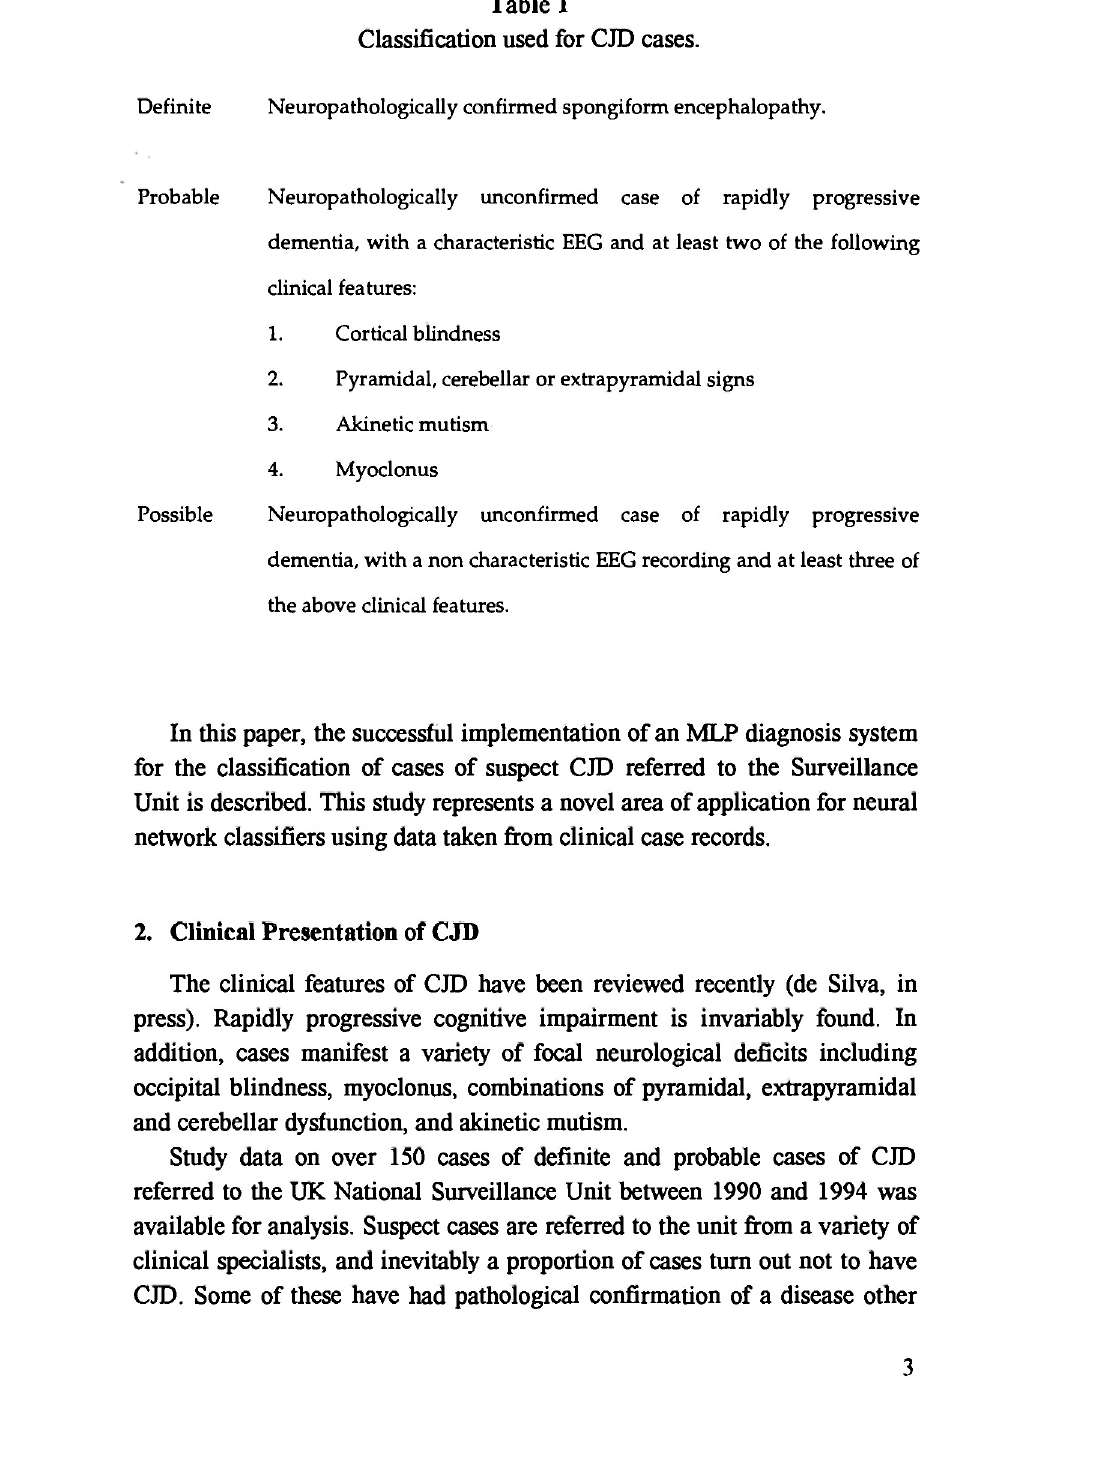
Classification used for CJD